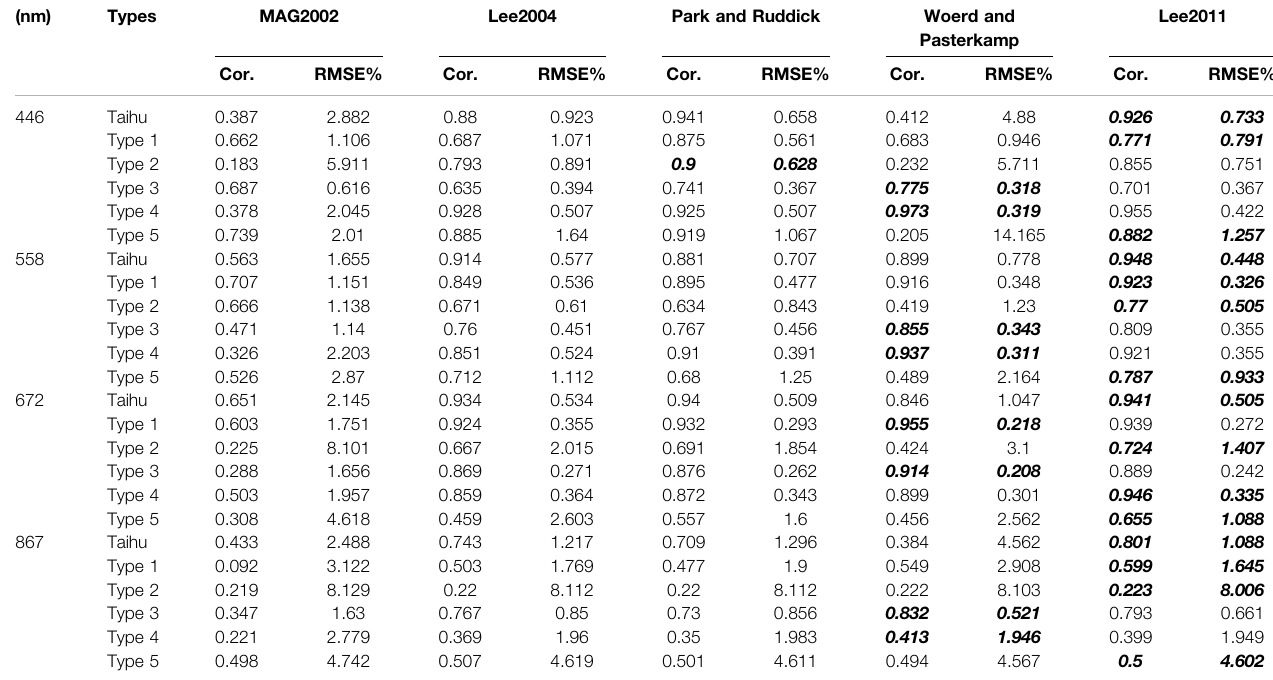
TABLE4| Statisticaldataforthe fi vemodelswithpriorparametersforTaihuLakeasawholeandforthe fi vewatertypes.Thebold-italicvaluesmeanthebestresultsinevery